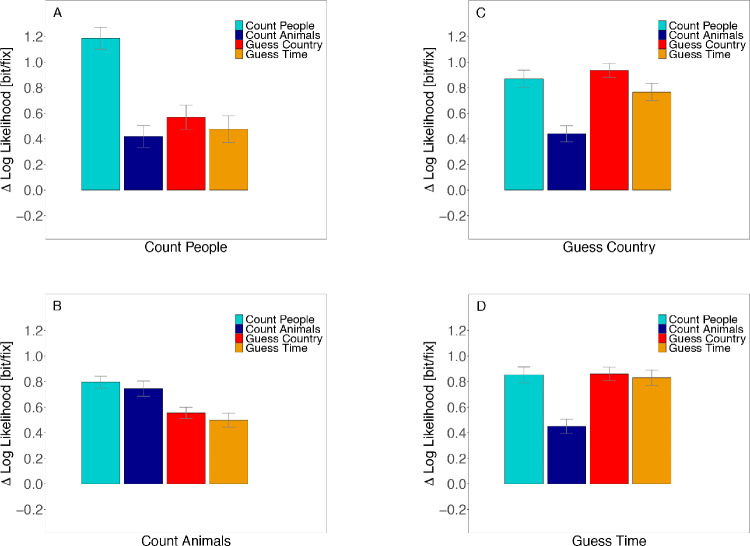
Average predictability of fixation locations in a task. Predictability was measured in bit per fixation as the average gain in log-likelihood of each fixation relative to a uniform distribution. Fixations were predicted from the distribution of all fixation locations measured under (A) Count People, (B) Count Animals, (C) Guess Country, and (D) Guess Time instruction. Confidence intervals were corrected for within-subject designs (Cousineau, 2005; Morey, 2008).